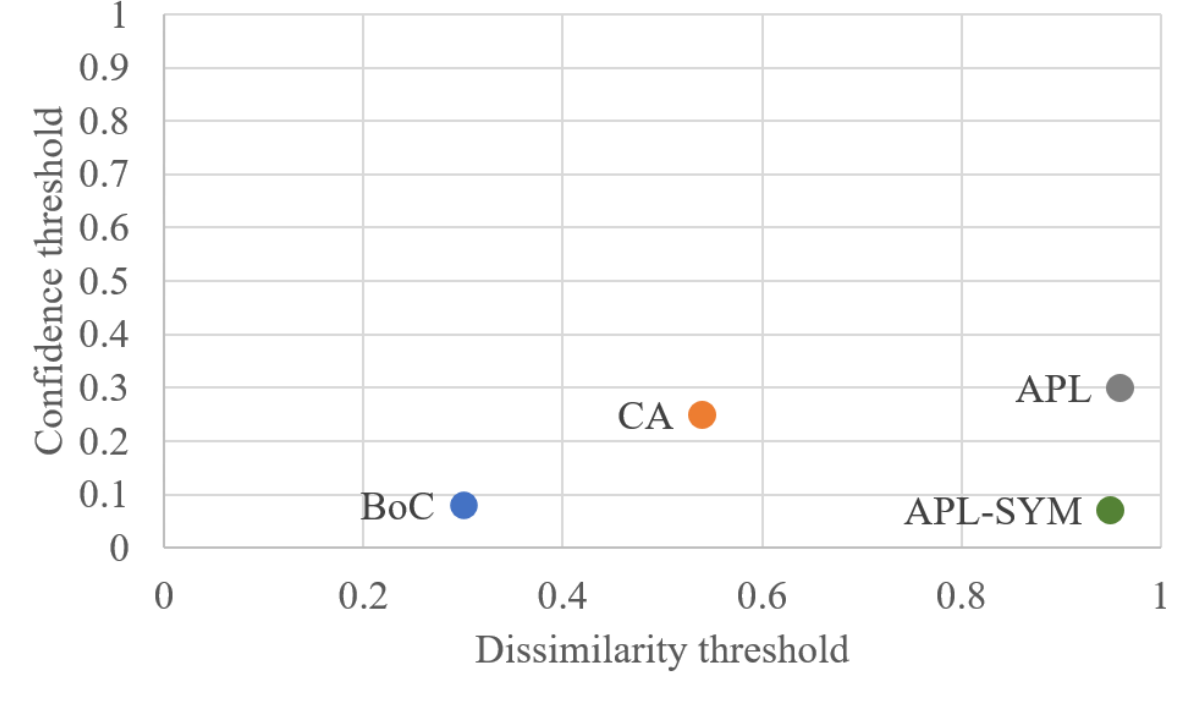
Figure 4. Representation of the optimal choice of the dissimilarity threshold τ and confidence threshold λ for the training data set. APL: average path length; BoC: bag-of-concept; CA: common ancestor; APL-SYM: symmetric average path